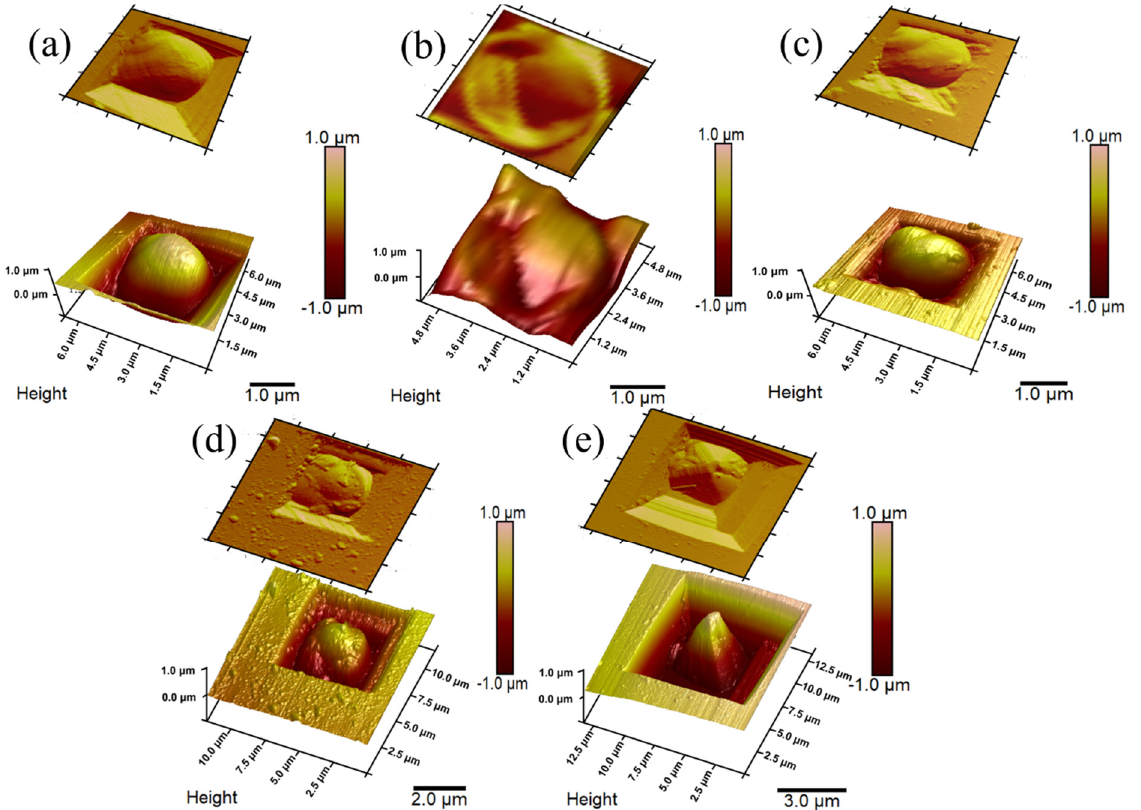
Figure 2. AFM images: ( a ) Non − modified yeast cell; ( b ) inactivated yeast cell; ( c ) PPy 0.05 − modified yeast cell; ( d ) PPy 0.1 − modified yeast cell; ( e ) PPy 0.3 − modified yeast cell.